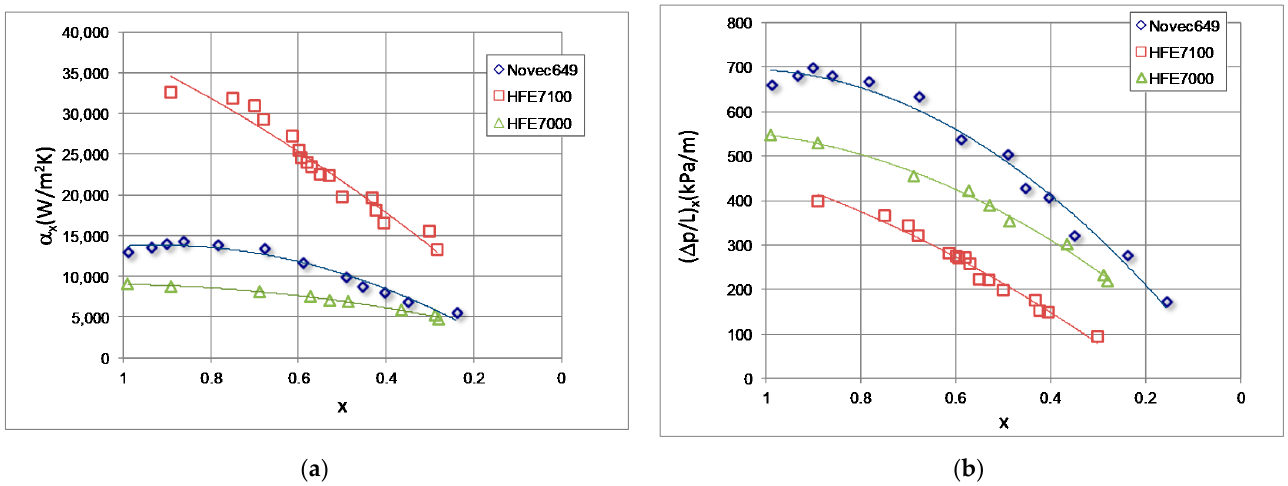
Figure 13. Comparison of our own exemplary results of Novec649, HFE7100 and HFE700 refrigerant condensations in a minichannel with an internal diameter of d i = 1.2 mm with a mass flux density of G = 4500 kg/m 2 s: ( a ) dependence of the heat transfer coefficient on the vapour quality α = f (x); ( b ) dependence of the pressure drop on the vapour quality ( ∆ p/L) = f (x) [24].